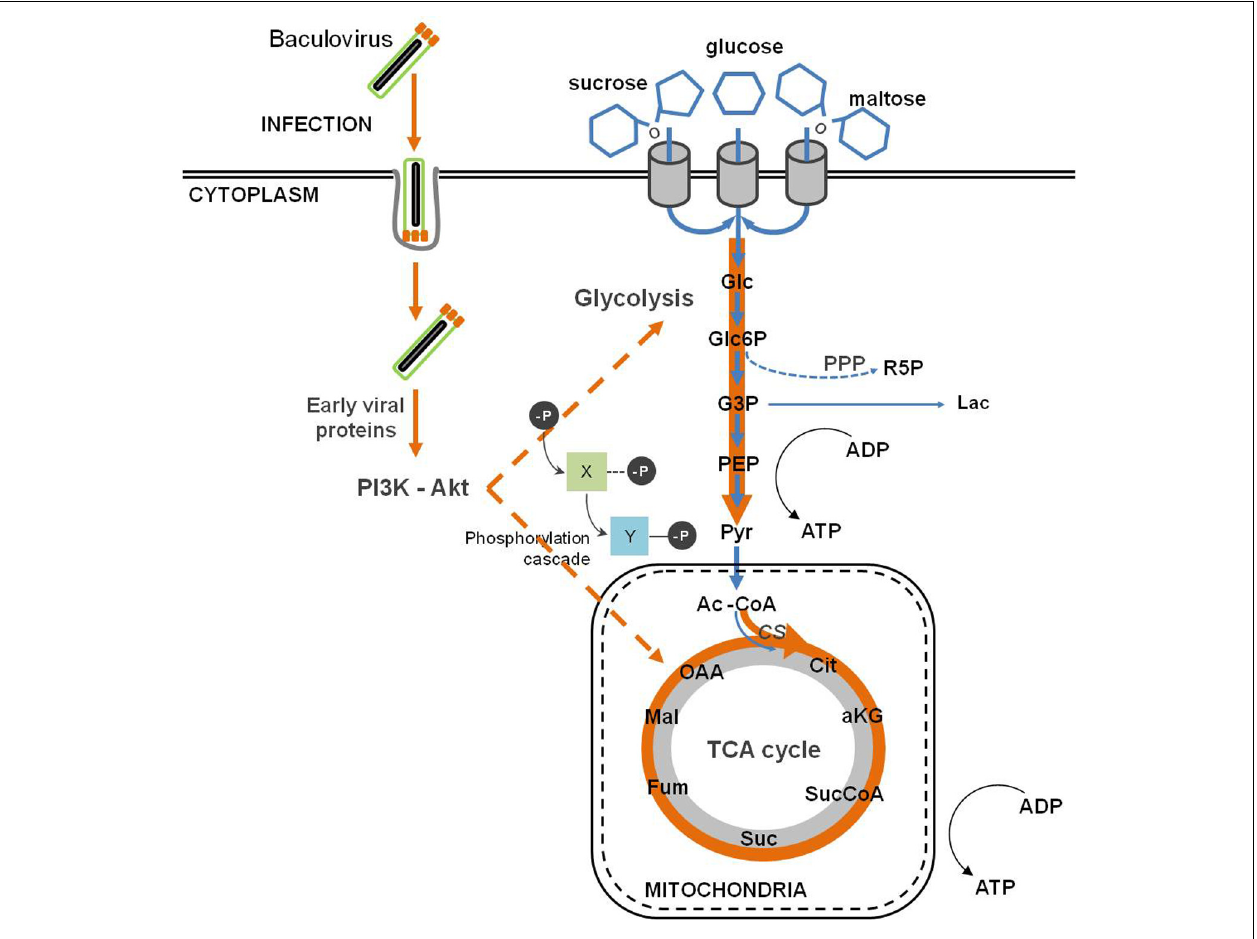
FIGURE 4 | Baculovirus infection impact on host cell metabolism. Baculovirus infection causes an intensification of glycolytic and tricarboxylic